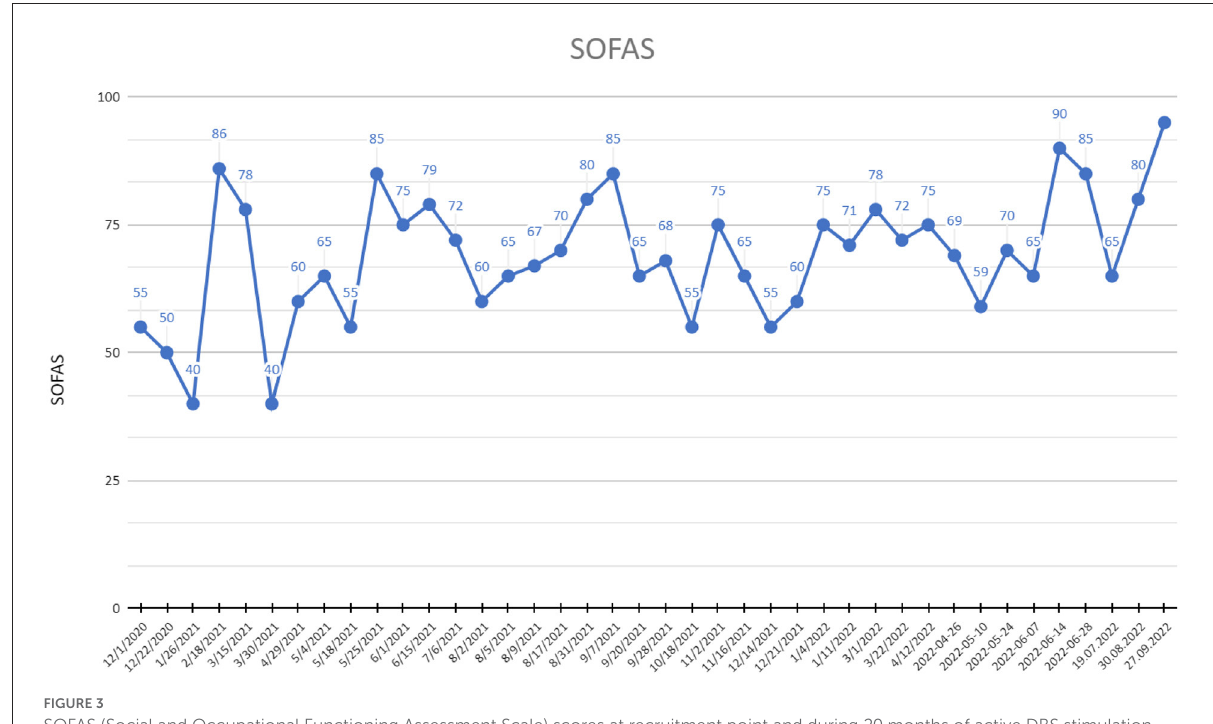
FIGURE3 SOFAS (Social and Occupational Functioning Assessment Scale) scores at recruitment point and during 20 months of active DBS stimulation